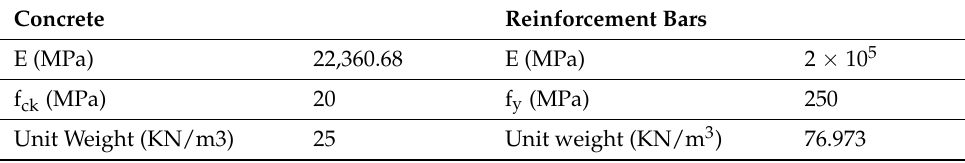
Table 2. Materials properties of case study